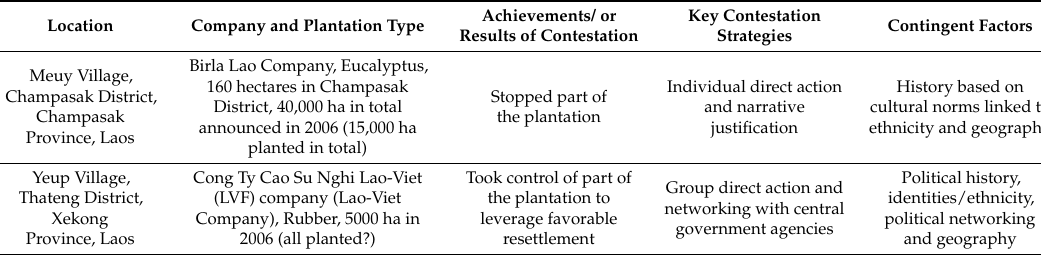
Table 1. Summary of the four case